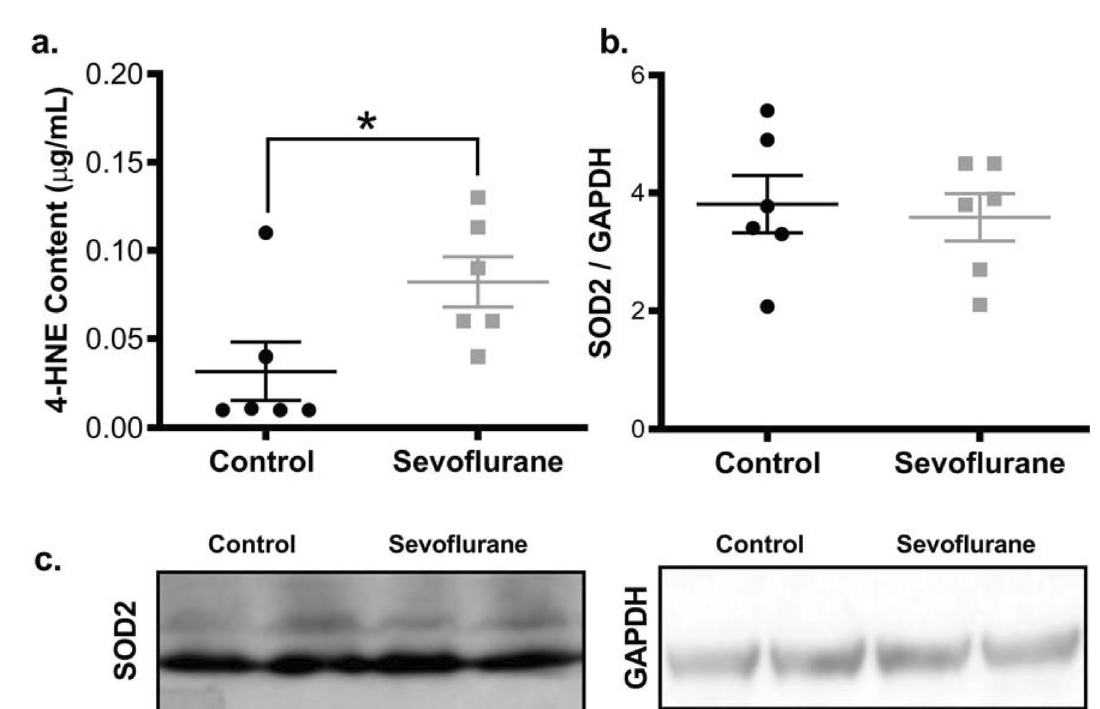
Figure 5. Adult rat cortex demonstrates long-term oxidative damage following P7 sevoflurane exposure. Lipid peroxidation adducts (4-HNE) were increased in sevoflurane exposed rat brains ( a ), indicating persistent oxidative stress. However, SOD2 has not increased, indicating the lack of a compensatory mitochondrial anti- oxidant response ( b , c ). Values represent means ± SEM, with 6 animals in each group. Statistical significance between groups indicated with (*) for p -value < 0.05. All samples derived from same experiment and gels/blots processed in